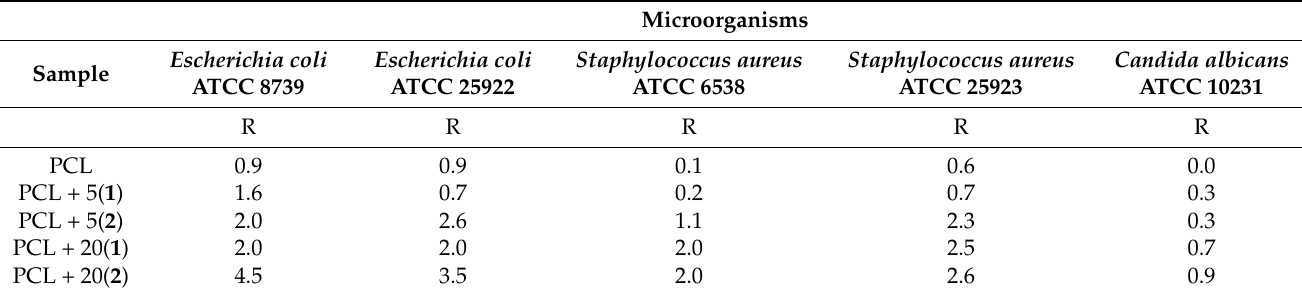
Table 6. Antimicrobial activity of PCL and PCL + n